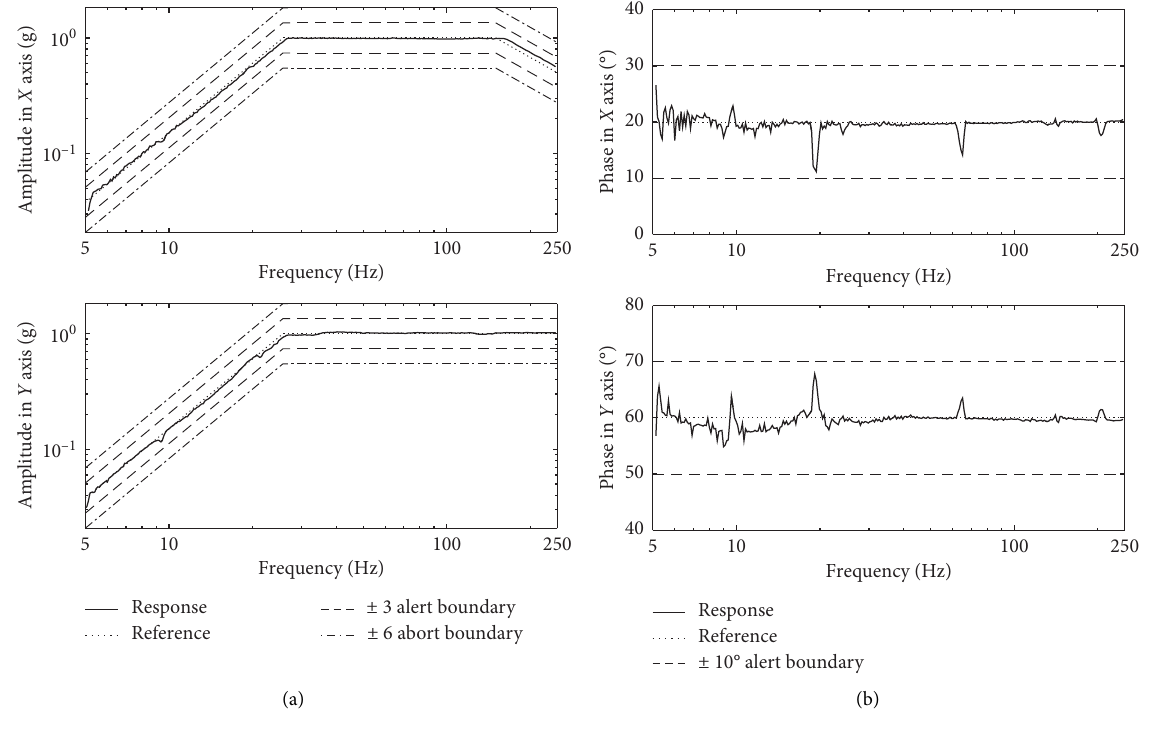
Figure 13: Responses of the normal level test after